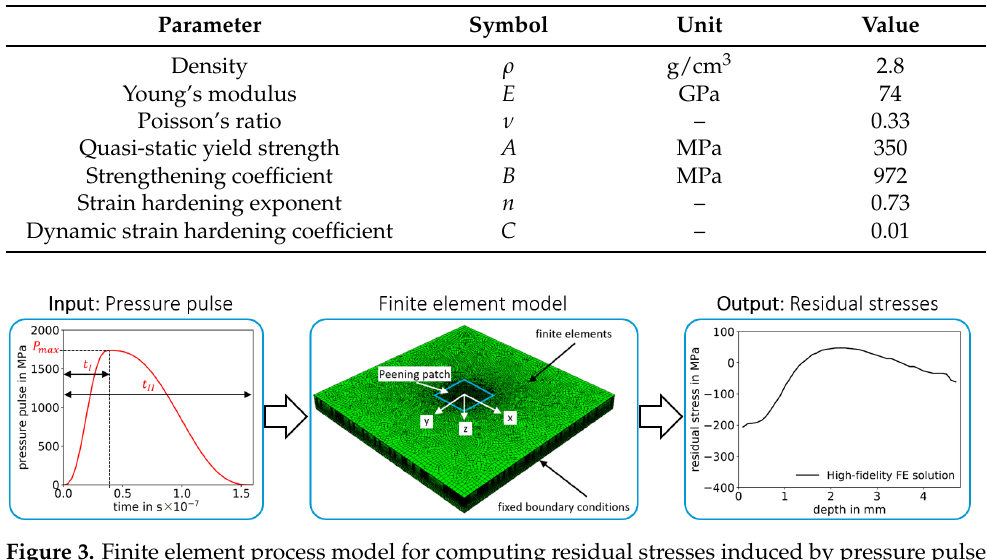
Table 1. Elastic and Johnson–Cook material parameter representative for aluminium alloy AA2024